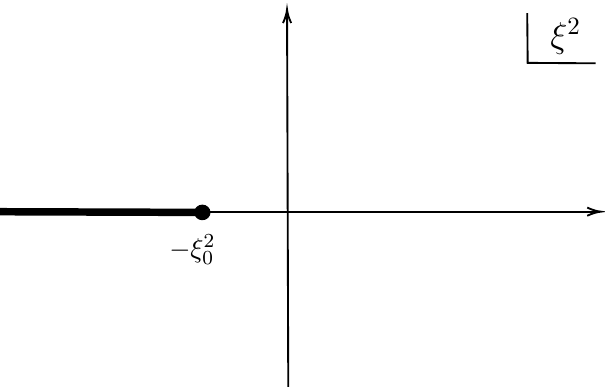
Figure 1 . Analyticity structure of F ( ξ 2 ) and M ( ξ 2 ) at complex ξ 2 plane in the high temperature domain ( T > T c ). The branching point located at ξ 2 = − ξ 2 extends from − ξ 2 to −∞ , which represents the line of first order phase 0